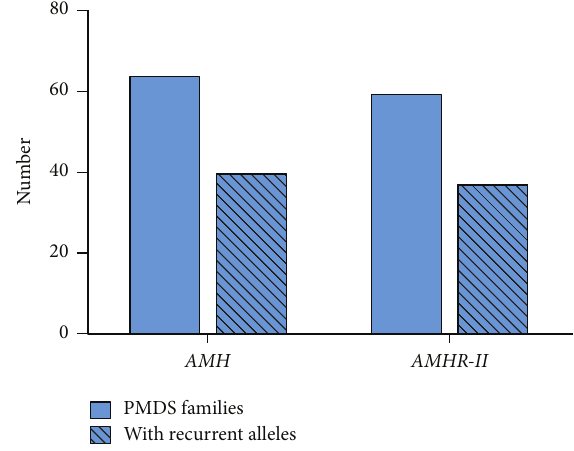
Figure 5: Recurrent alleles in families with persistent M¨ullerian duct syndrome (PMDS). Number of PMDS families and number of families with recurrent alleles. PMDS: persistent M¨ullerian duct syndrome; AMH : anti-M¨ullerian hormone gene; AMHR-II : anti- M¨ullerian hormone receptor type II